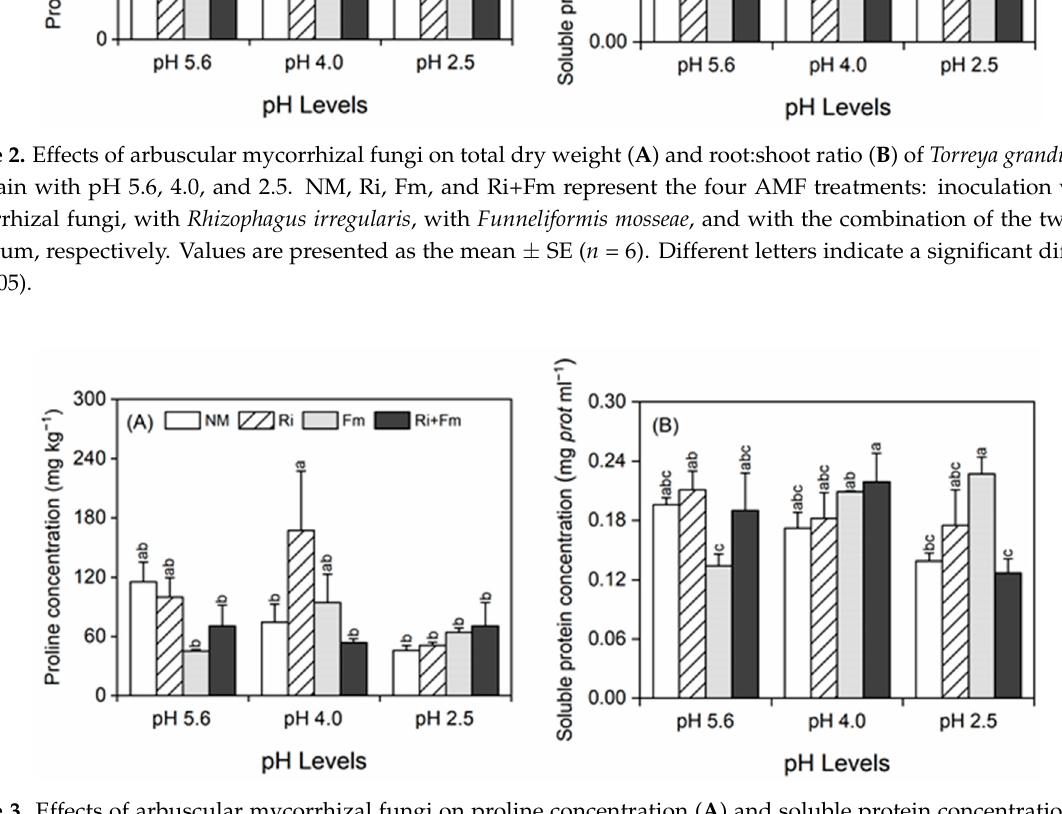
Figure 2. Effects of arbuscular mycorrhizal fungi on total dry weight ( A ) and root:shoot ratio ( B ) of Torreya grandis under acid rain with pH 5.6, 4.0, and 2.5. NM, Ri, Fm, and Ri+Fm represent the four AMF treatments: inoculation with no mycorrhizal fungi, with Rhizophagus irregularis , with Funneliformis mosseae , and with the combination of the two fungi inoculum, respectively. Values are presented as the mean ± SE ( n = 6). Different letters indicate a significant difference ( p < 0.05).